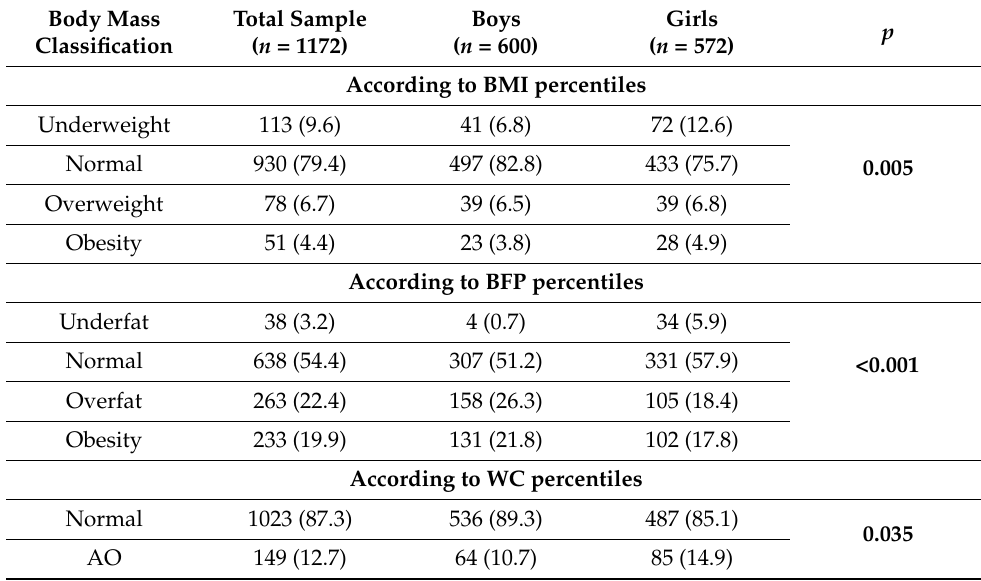
Table 1. Prevalence of obesity defined based BMI, BFP, and WC percentiles. Body